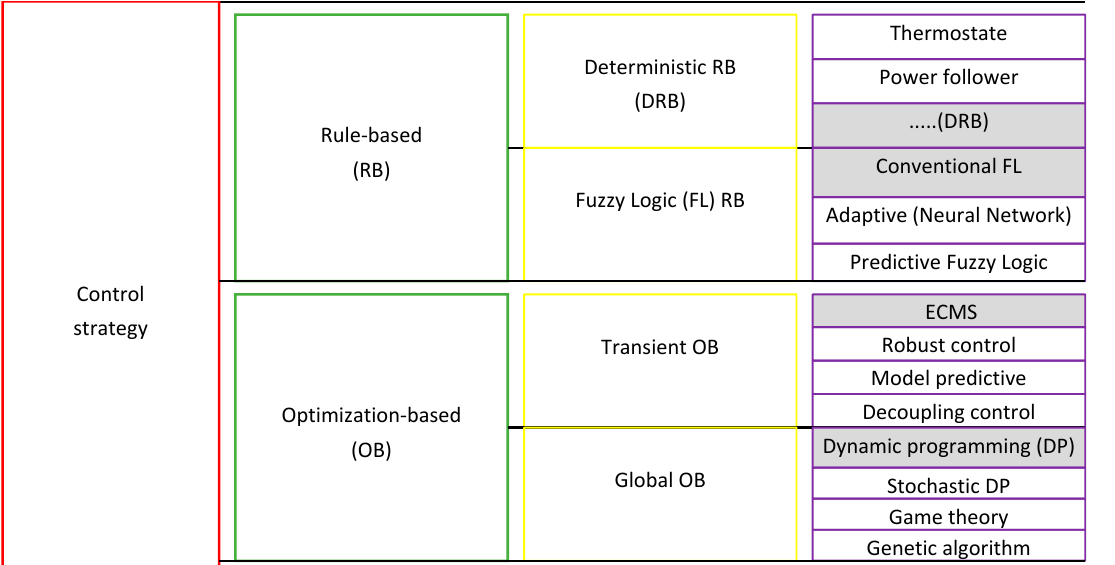
Figure 2. Classification of control strategies (CsTs). ECMS: equivalent consumption minimization